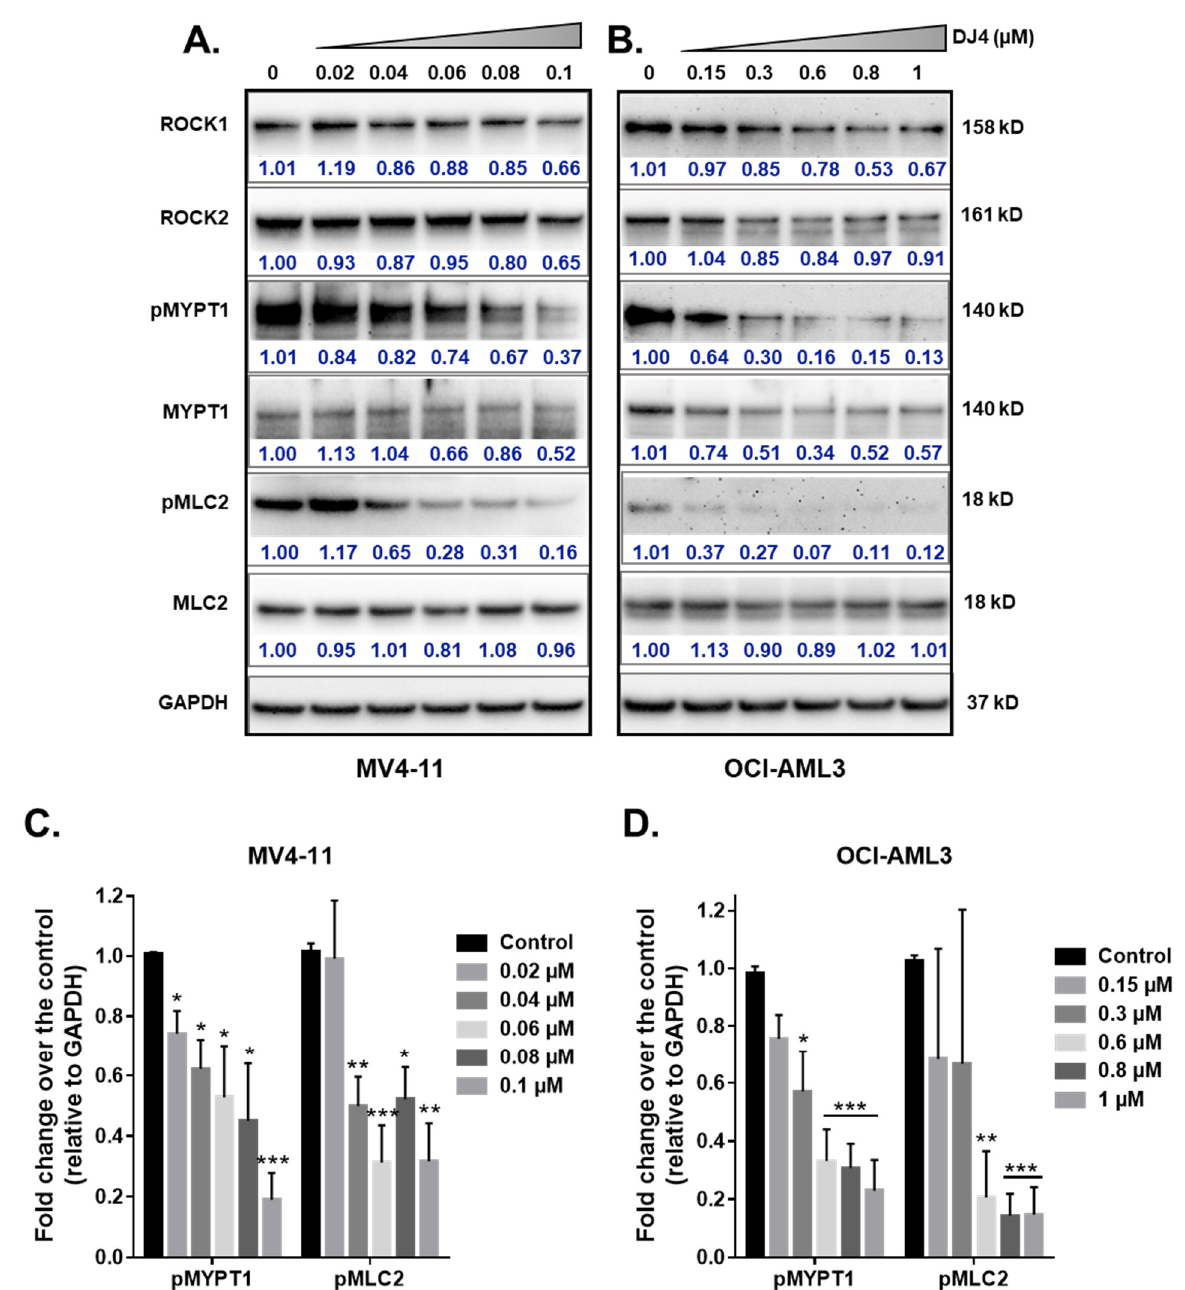
Figure 4. DJ4 effectively inhibits downstream ROCK substrates in human AML cell lines. Immunoblot analysis of the relative activity of MYPT1, MLC2, and expression levels of ROCK1, and ROCK2 upon treating the whole cell lysates of ( A ) MV4-11 and ( B ) OCI-AML3 with DJ4 for 24 h. The phosphorylated levels of MYPT1 and MLC2 relative to the loading control GAPDH in ( C ) MV4-11 and ( D ) OCI-AML3 in the presence of DJ4 were quantified. The data were representative of three independent experiments. The results were assessed by means of the unpaired t -test and * p < 0.05, ** p < 0.01, and *** p < 0.005 were considered significant. The data are the means ± SEM ( n = 3).